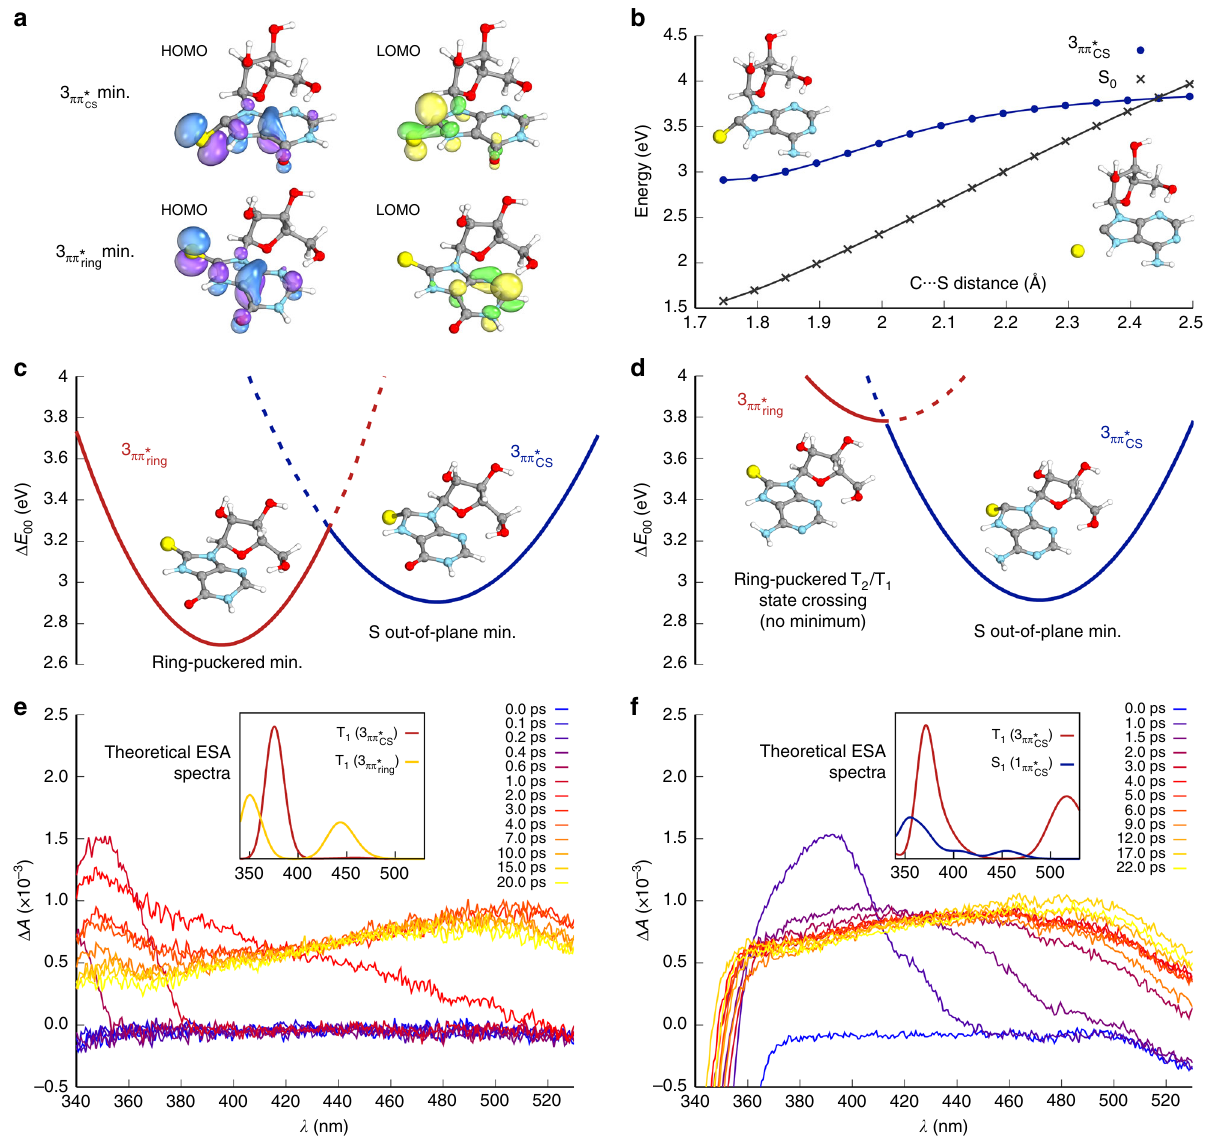
Fig. 3 Photochemical properties of ara -5I and ara -5A . a Molecular orbitals for T 1 states ( 3 ππ CS * and 3 ππ ring *) of ara -5I . b Calculated potential energy pro fi le of ara -5A T 1 3 ππ CS * state C – S bond homolysis furnishing triplet sulfur atom and singlet C8-carbene tautomer of ara -4A . Blue line = T 1 -state energy, black line = ground-state energy. The minimum-energy path along the C – S distance (Å) was obtained by calculation at the ADC(2)/cc-pVTZ level of theory. c Calculated ara -5I triplet excited state T 1 topography. Parabolas fi tted to calculated T 1 minima energies and optimised T 2 /T 1 minimum-energy state crossing, which represents the transition state between these minima. d Calculated ara -5A triplet excited state T 1 topography. No ring-puckered minimum was found on the T 1 hypersurface due to the higher 3 ππ ring * state energy. e – f FTAS recorded between λ = 340 and 530 nm with λ = 290 nm excitation (pump) pulses. e FTAS of ara -5I recorded between λ = 340 and 530 nm with λ = 290 nm excitation (pump) pulses. Inset: Calculated excited state absorption spectra for the two possible con fi gurations of ara -5I . f FTAS of ara -5A recorded between λ = 340 and 530 nm with λ = 290 nm excitation (pump) pulses. Inset: Calculated excited state absorption spectra for the singlet and triplet states of ara -